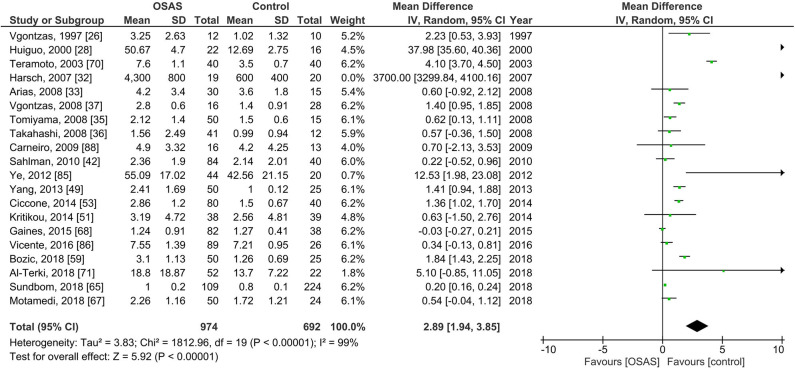
Forest plot of random-effects analysis of plasma interleukin-6 levels in adults. The diamond shape indicates the pooled mean difference (MD). Each black box represents a point estimate of each study and also gives a representation of the study size (the bigger the box, the more participants in the study). A horizontal line representing the 95% confidence intervals (CIs) of the study result, with each end of the line representing the boundaries of CI. SD, standard deviation; OSAS, obstructive sleep apnea syndrome.